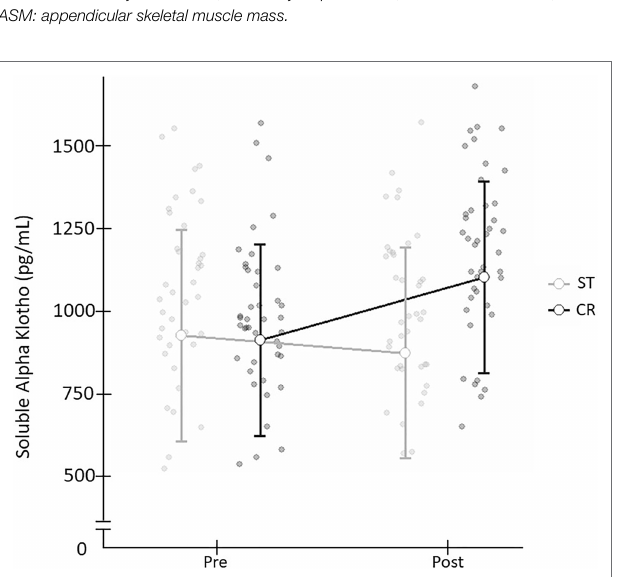
Results shown as the mean and standard deviation (mean ± SD). Significance set at p < 0.05. BMI: body mass index; BAI: body adipose index; VFA: visceral fat area; ASM: appendicular skeletal muscle mass.